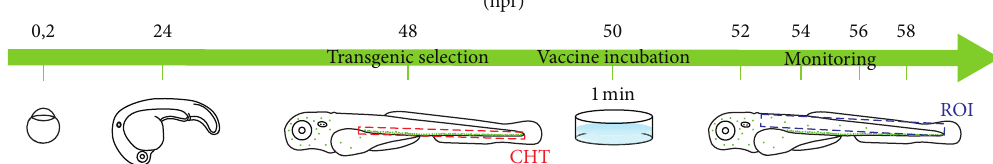
Figure 1: Scheme of vaccine assay. At 48 hpf Tg(mpx:GFP) i114 nonactivated zebrafish larva, with neutrophils located only in the CHT (demarked in red), was selected, bath-incubated, and quantified the number of neutrophils mobilized to the region of interest (ROI, demarked in blue) at 2, 4, 6, and 8